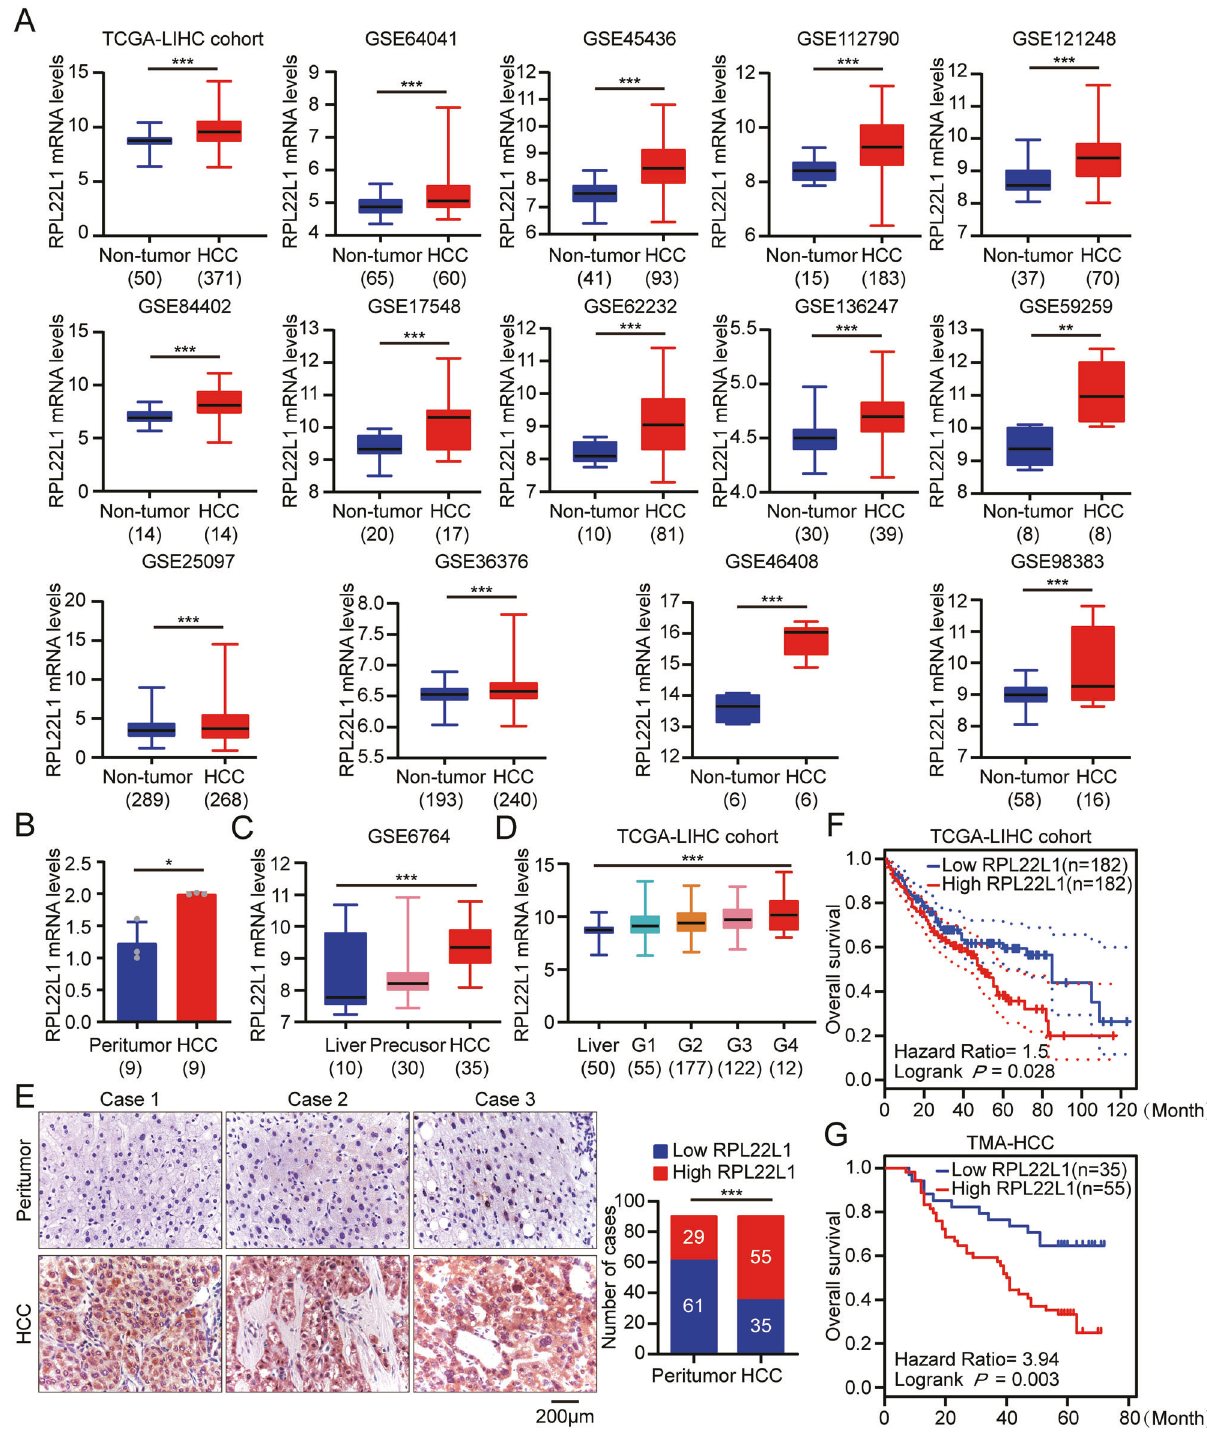
Fig. 1 Expression and prognosis importance of RPL22L1 in HCC. A RPL22L1 mRNA levels in HCC and non-tumorous tissues were compared through TCGA and 14 independent GEO data sets. B RT-PCR analysis of RPL22L1 mRNA in 9 paired clinical HCC and adjacent non-tumor tissues. C RPL22L1 mRNA expression during HCC progression from GSE6764 dataset. D RPL22L1 mRNA expression in different grades of HCC from TCGA-LIHC dataset. E Representative images and score statistics of RPL22L1 IHC staining in 90 paired HCC and adjacent tissues. Case 1 – 3 represented 3 HCC patients, respectively. Scale bars = 200 μ m. Kaplan-Meier survival curves according to RPL22L1 expression in F TCGA-LIHC dataset and G TMA-HCC data (log-rank test). * P < 0.05, ** P < 0.01, *** P < 0.001.